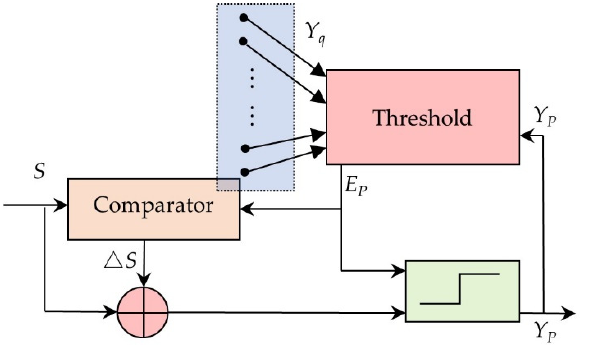
Figure 3. Structure of the improved PCNN.